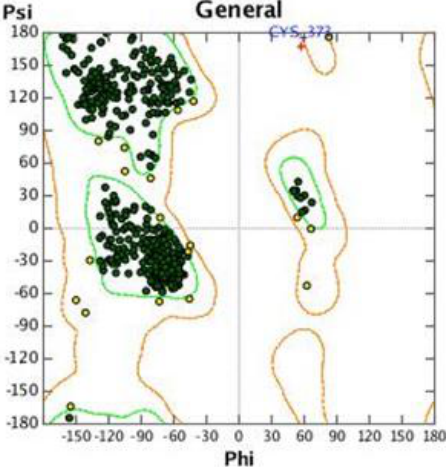
Figure 10. Ramachandran plots of the AFB5 structural